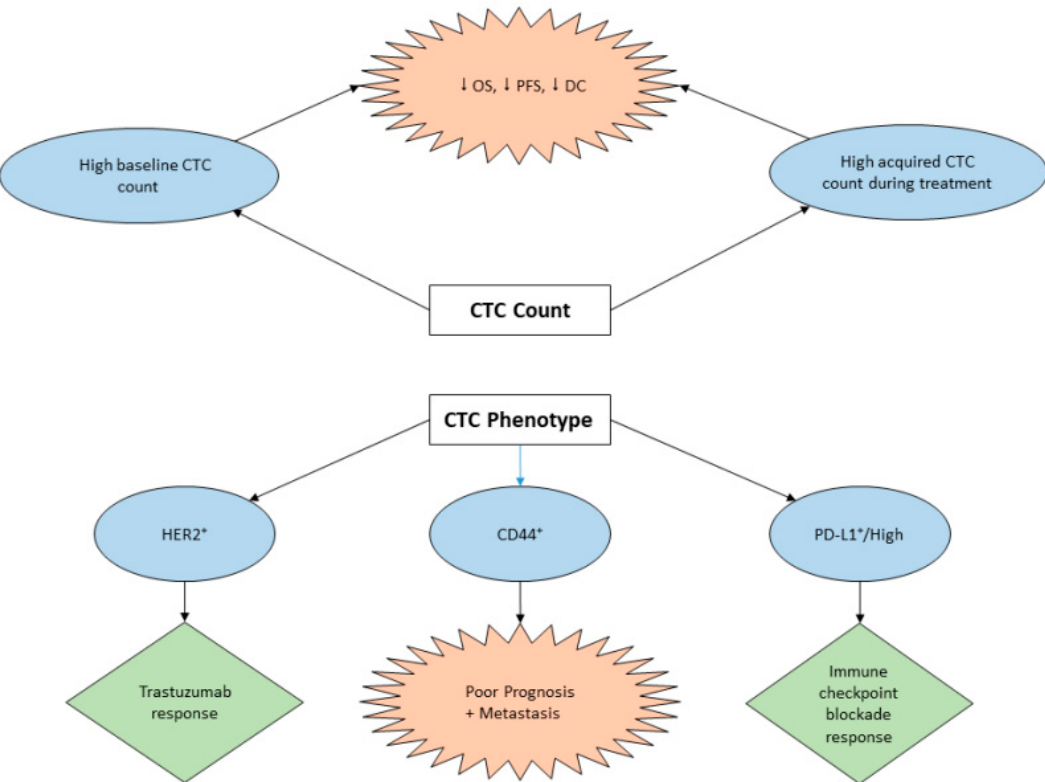
Figure 1 . The predictive utility of CTCs in gastric cancer treatment. High baseline or acquired CTCs count was associated with decreased OS, PFS, and DC. The HER2 and PD-L1 positivity or high amplification could predict positive response to trastuzumab and checkpoint therapy, respectively.